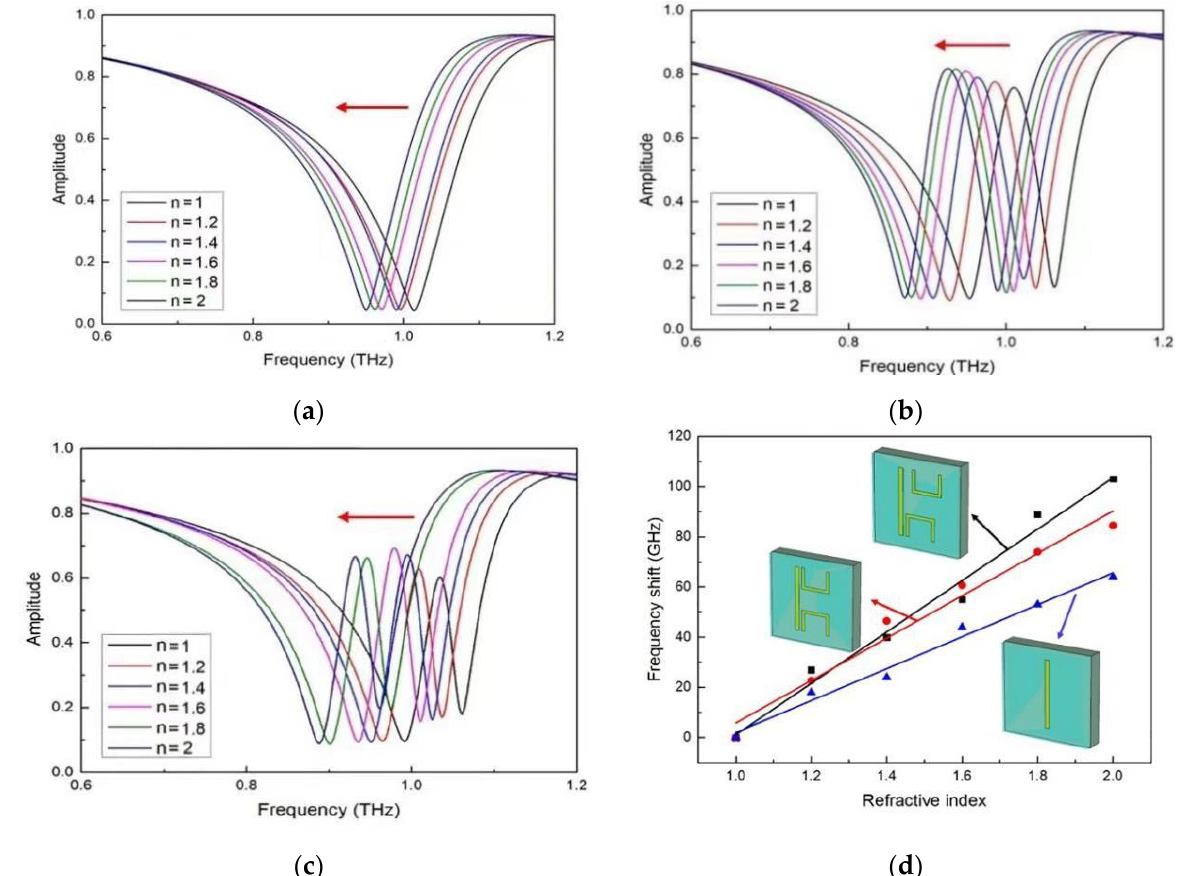
Figure 9. The influence of refractive index changes on the transmission spectra. ( a ) The transmission spectra of CW resonance peak varying with refractive index; ( b ) The transmission spectra of EIT-like window with unilateral symmetric structure varying with refractive index; ( c ) The transmission spectra of the EIT window with unilateral asymmetric structure varying with refractive index. With the increase of the refractive index of the dielectric layer, the resonance peak and the transparent window are red-shifted; ( d ) Linear fitting of the refractive index sensitivity against the drift of the peak frequency of three metamaterials